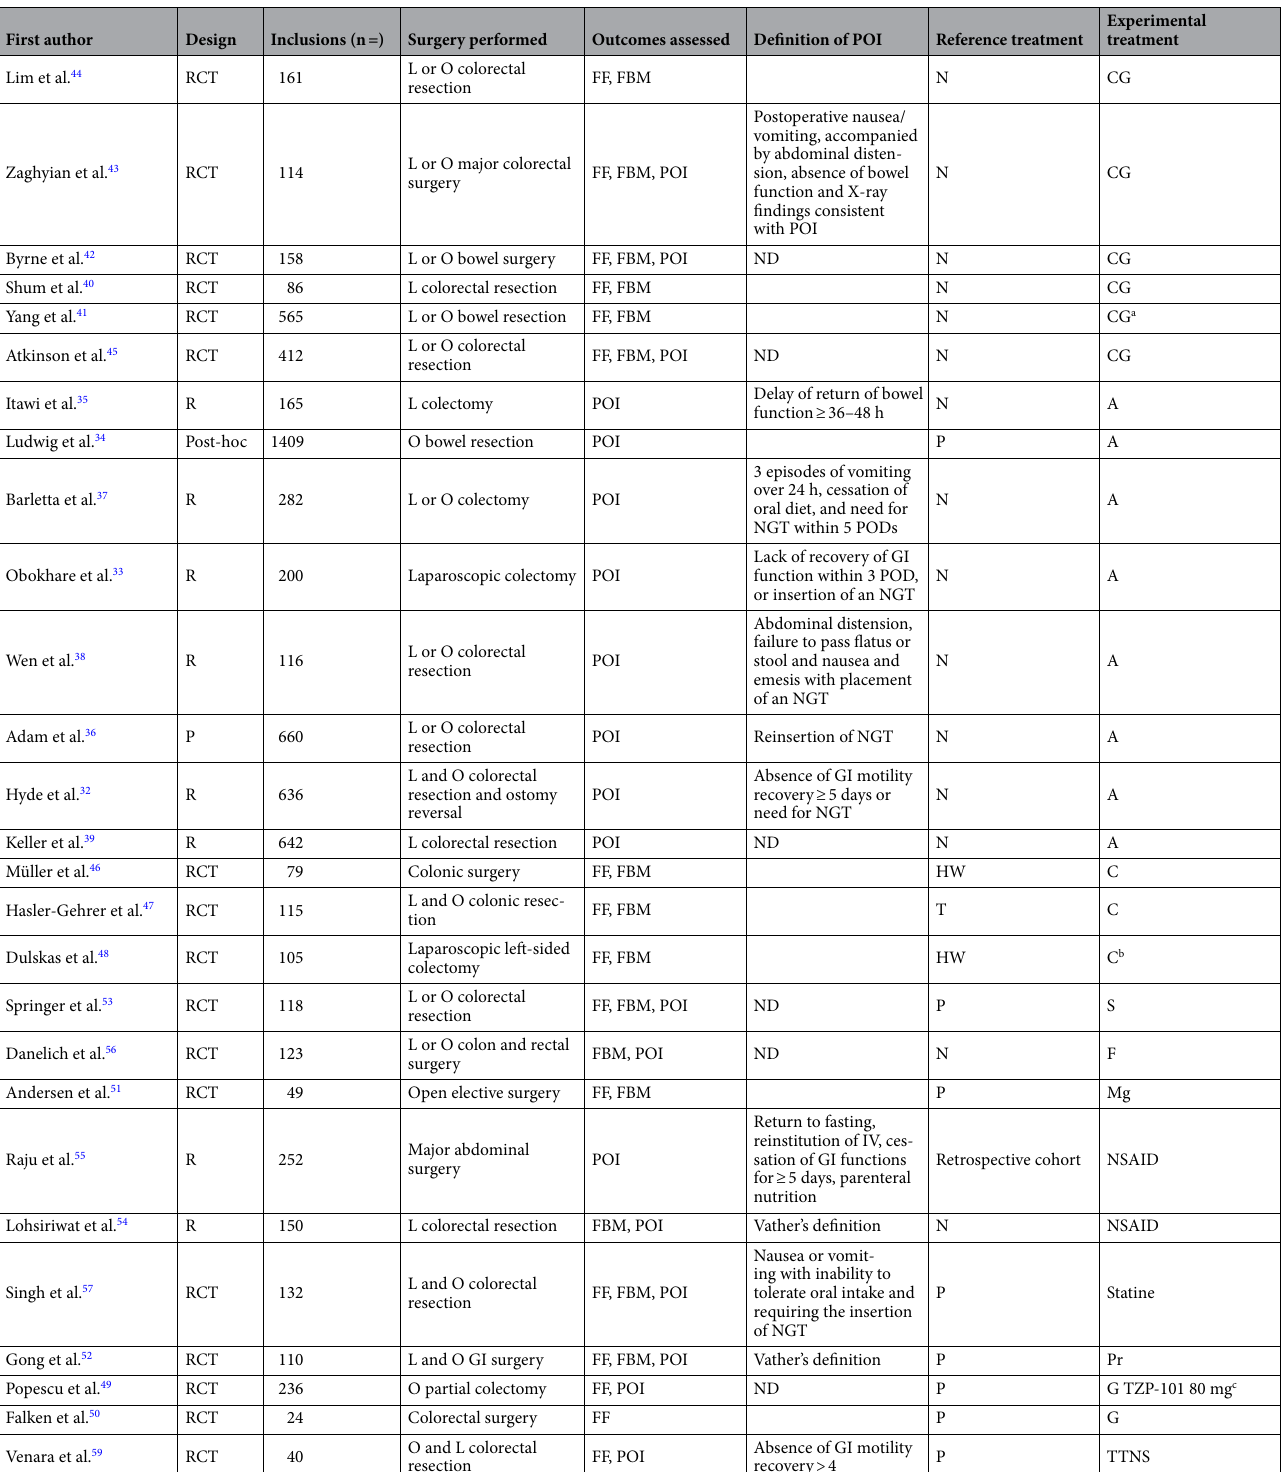
Table 2. Systematic review of the studies assessing preventive treatment for POI. MA: meta-analysis, NMA: network meta-analysis, RCT: randomised controlled trial, R: retrospective, FF: time to first flatus, FBM: time to first bowel movement, POI: postoperative ileus, L: laparoscopic, O: open, GI: gastrointestinal, ND: not defined, POD: postoperative day, NGT: nasogastric tube, P: placebo, N: none, P: placebo, CG: chewing gum, A: alvimopan, C: Coffee, S: simethicone syrup, F: Furosemide, NSAID: non-steroidal anti-inflammatory drugs, Pr: prucalopride, G: ghrelin, TTNS: transcutaneous tibial nerve stimulation. Third group: a